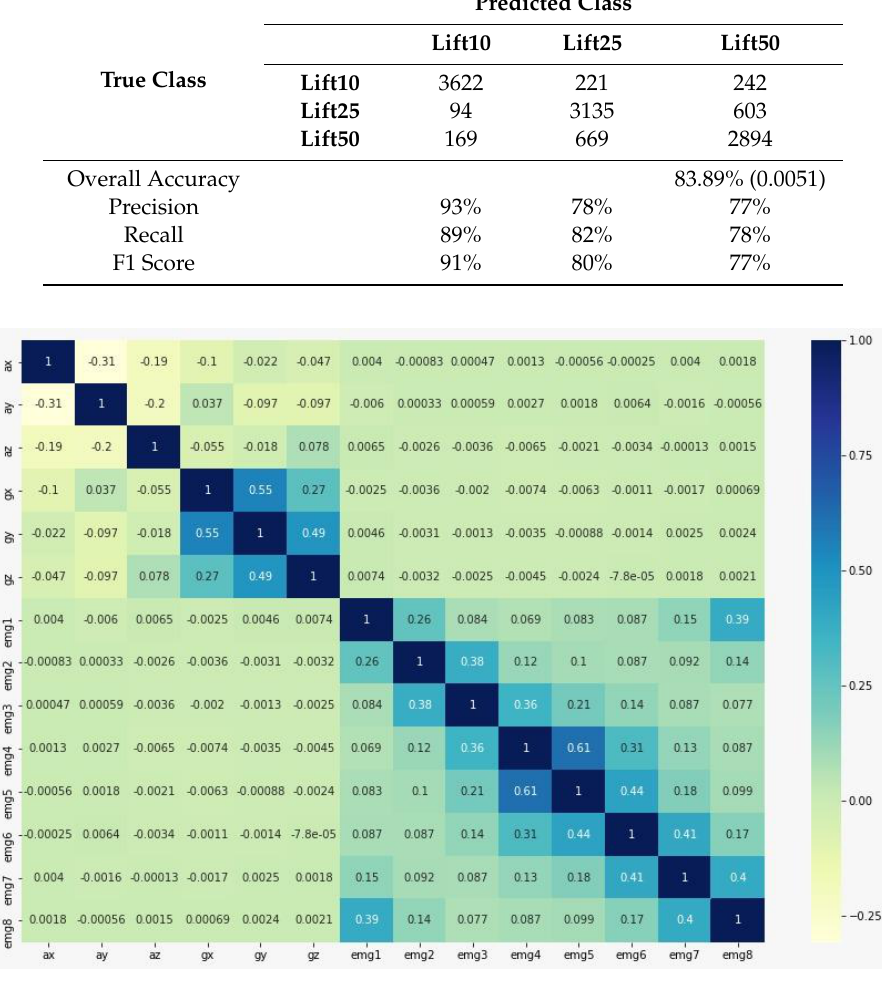
Figure 9 . Correlation of features for three (10 lbs, 25 lbs, and 50 lbs) lifting weights. Figure 9. Correlation of features for three (10 lbs, 25 lbs, and 50 lbs) lifting